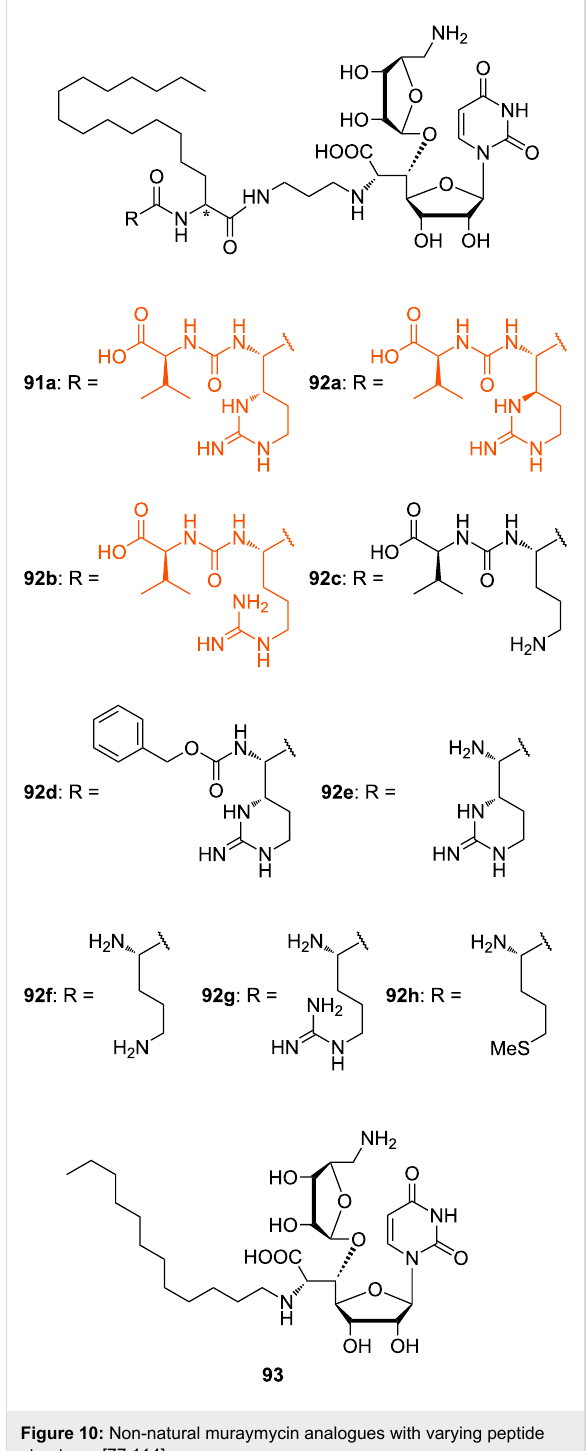
Figure 10: Non-natural muraymycin analogues with varying peptide structures [77,114].